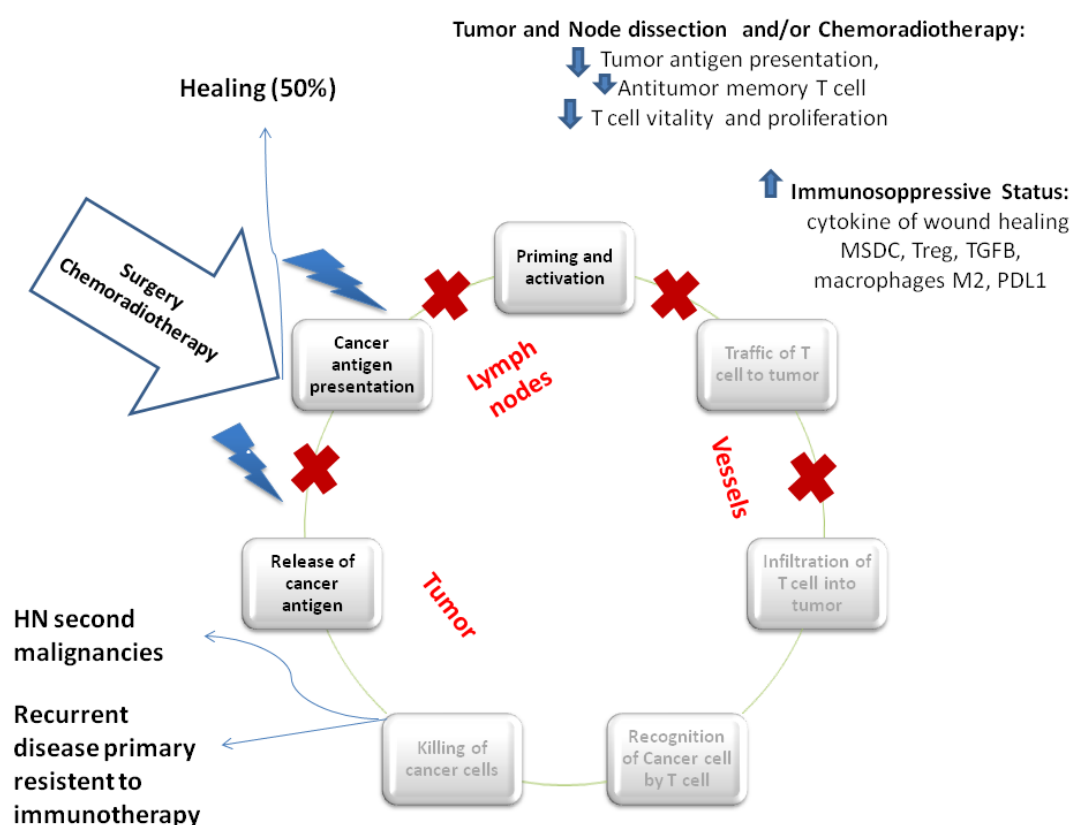
Figure 2. Locoregional treatment and immunity cycle. Locoregional treatment could block the immunity cycle at different level. Primary tumor resection induces a reduction in tumor antigen presentation, T cell activity, and, at the same time, the development of anti-tumor specific memory T cell which is definitively compromised by local lymph nodes dissection. The first postoperative phase is characterized by the increase of cytokines of wound healing, PD-L1 expression, myeloid-derived suppressor cells (MDSC), macrophages M2, and Treg. Similarly, radiotherapy promotes the release of cancer antigen through the induction of immunogenic cell death, increasing the antitumor T cell response and cross antigen presentation. Contemporarily, radiotherapy could promote an immunosuppressive status through the increase of local MDSC, PD-L1 expression, Treg, and macrophages M2. Healing occurs if all neoplastic cells have been radically removed after the intensive multimodal treatment and if micrometastatic disease is completely eradicated. However, head and neck second malignancies could occurr for impaired immunosurveillance. Recurrent disease with a primary induced resistance to immunotherapy is the result of an incomplete and ineffective first immune response.